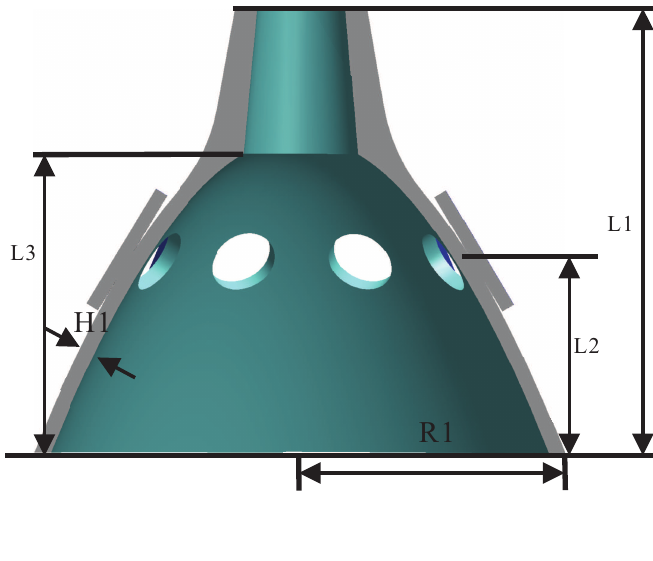
Table 1. The parameters with simulation.